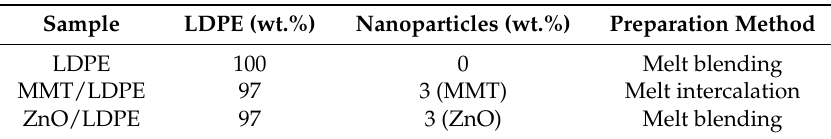
Table 1. Different tested